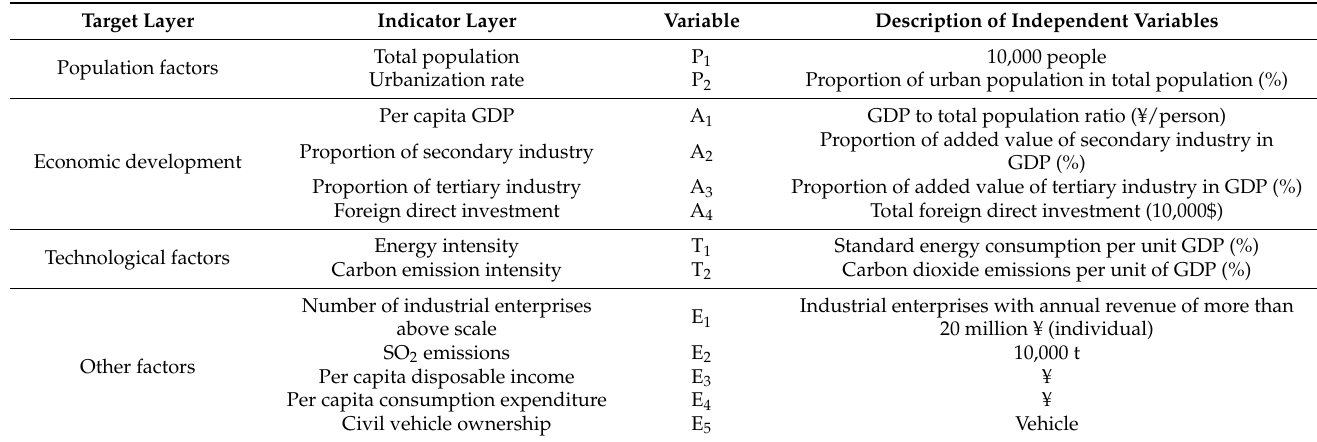
Table 2. Indicator Description of Carbon Emission Influencing